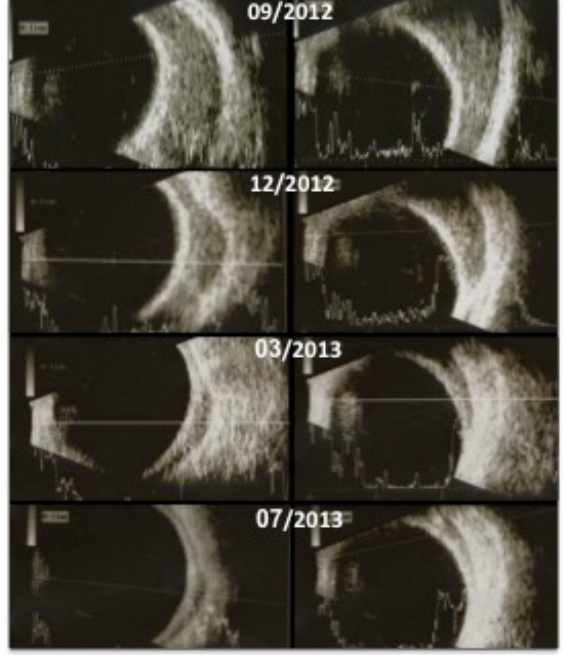
Figure 2: Consecutive ultrasounds of the left eye – superior transversal view (left column) and lateral transversal view (right column) – documenting progressive resolution of the lacrimal gland lesion after radiation therapy treatment was performed in November